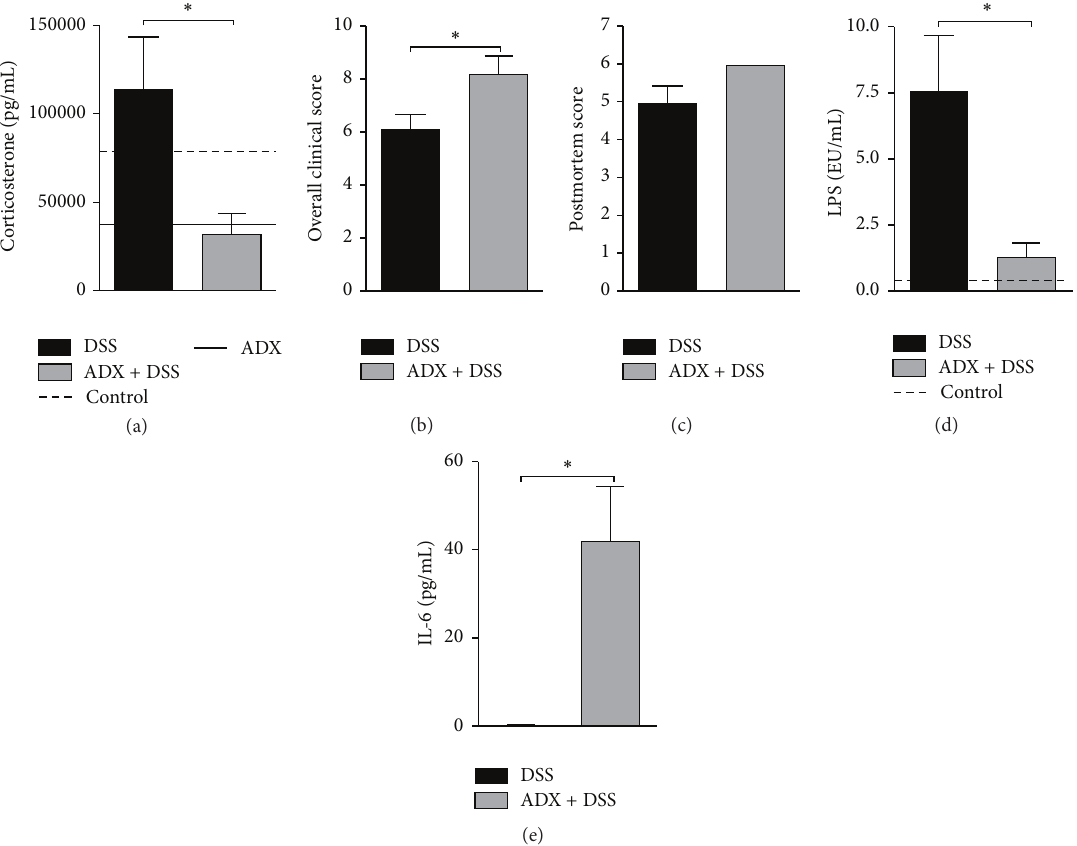
Figure1:Adrenalglandsareimportanttocontrolclinicaloutcomeinexperimentalcolitis . C57BL/6micewereadrenalectomizedandexposed to dextran sulfate sodium (DSS) 3%. On day 6 mice were euthanized to obtain samples of serum: (a) plasma corticosterone levels; (b) overall clinical score of the disease; (c) postmortem score; (d) serum IL-6 levels; (e) serum lipopolysaccharide (LPS) levels. DSS: C57BL/6 mice exposed to DSS; ADX + DSS: C57BL/6 adrenalectomized mice exposed to DSS. The dashed lines correspond to the control group of C57BL/6 mice not exposed to DSS. Continuous line in (a) corresponds to adrenalectomized mice without colitis. EU/mL = endotoxin units/mL. These results are representative of 3 independent experiments with 5 mice/group. ∗ 𝑝 < 0.05